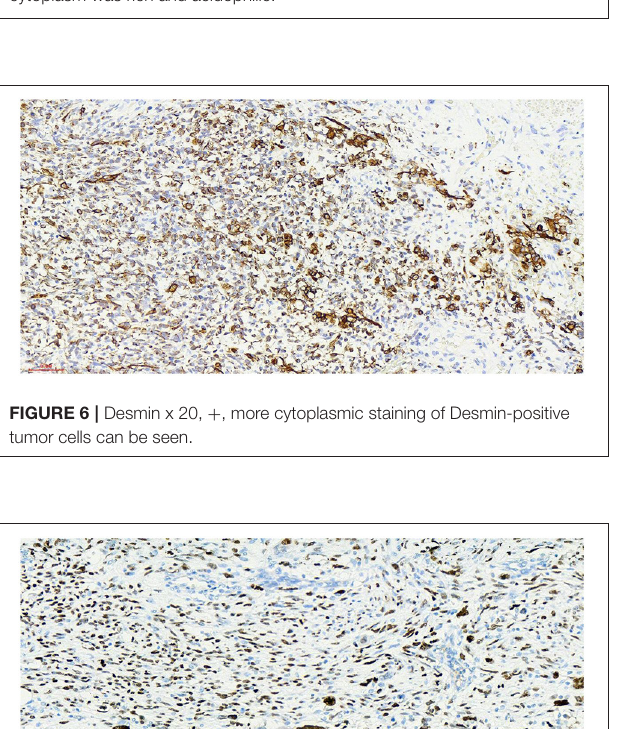
Figure 9 ). The pathological diagnosis was rhabdomyosarco-ma of the right testis. The postoperative chromosome karyotype analysis showed that there was no Y chromosome